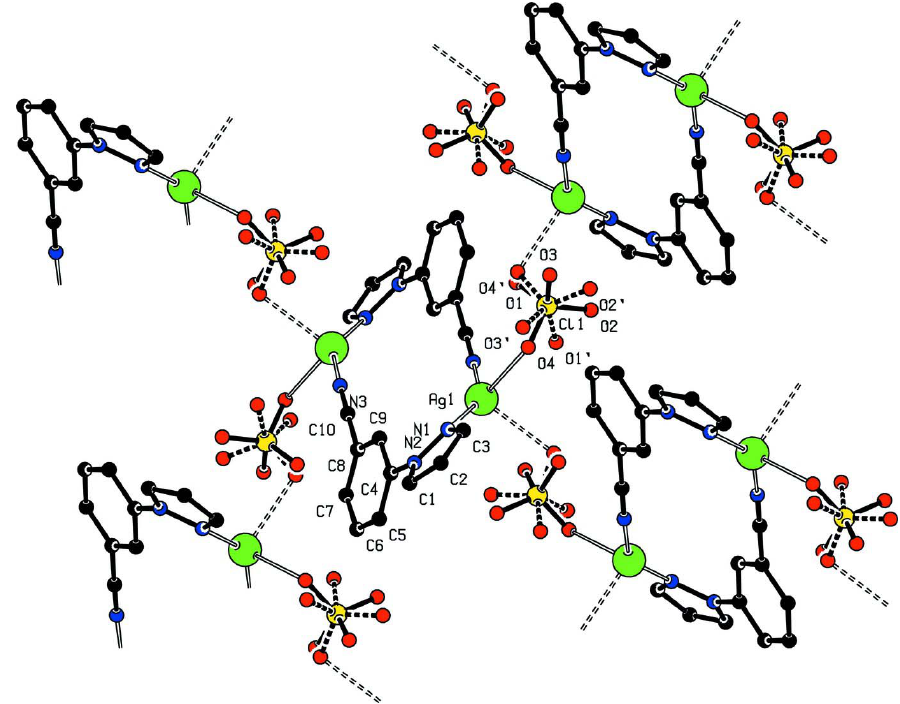
Figure 3 Part of the crystal structure showing the major and minor (dashed bonds) components of